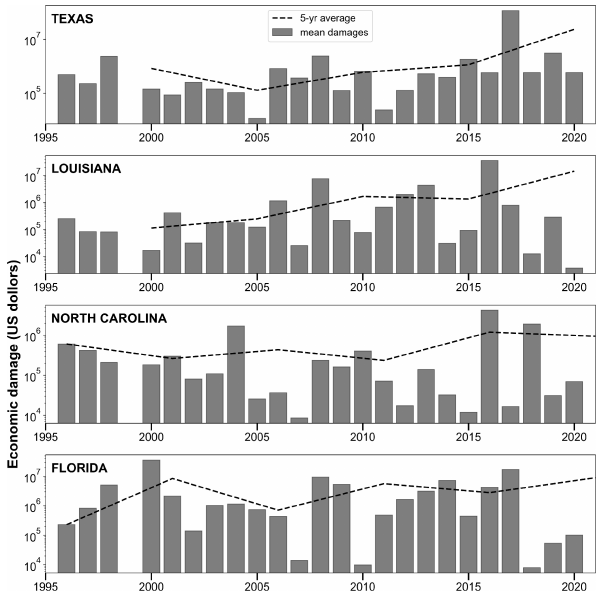
Figure 6. Time series of regional economic damages at 2020 val-